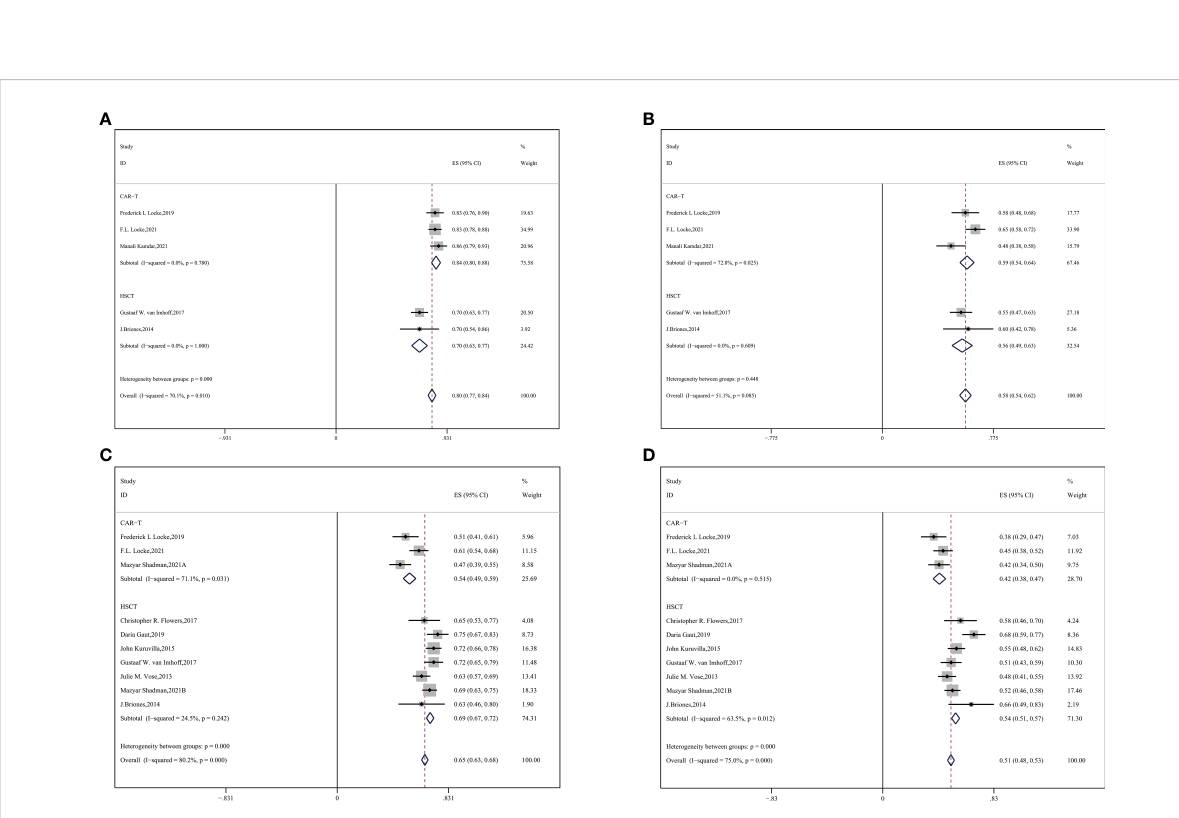
FIGURE 3 Subgroup analyses by age between CAR-T and auto-HSCT groups (A) ORR (B) CR (C) 2-year OS (D) 2-year